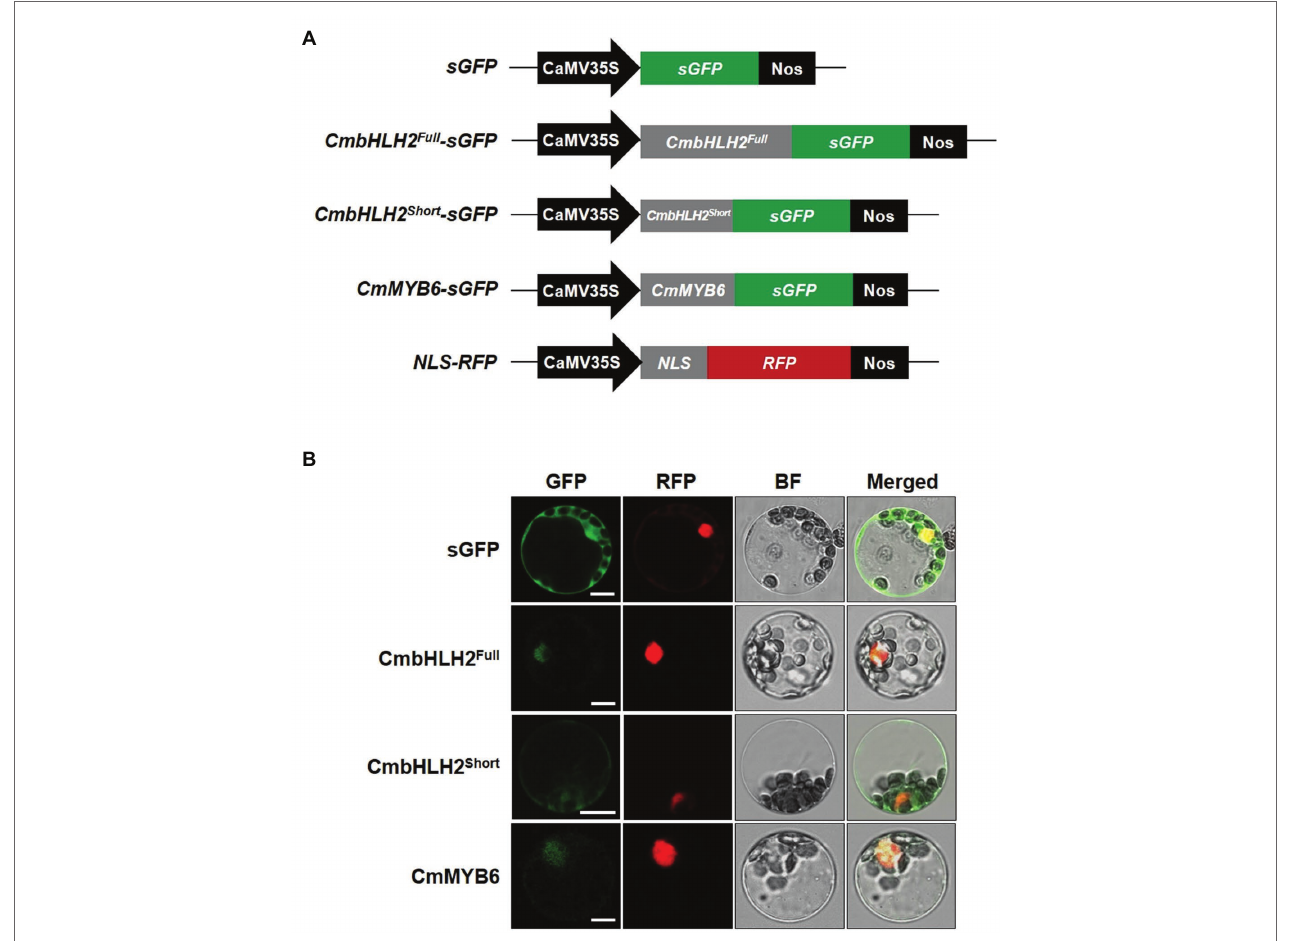
FIGURE 4 | Subcellular localization of CmbHLH2 Full , CmbHLH2 Short , and CmMYB6 in Arabidopsis leaf protoplasts. (A) Five constructs were used in this experiment: sGFP, soluble GFP; CmbHLH2 Full ::GFP, CmbHLH2 Full fused to GFP; CmbHLH2 Short ::GFP, CmbHLH2 Short fused to GFP; CmMYB6::GFP, CmMYB6 fused to GFP; and NLS::RFP, nuclear localization signal fused with RFP. (B) In vivo targeting of CmbHLH2 Full , CmbHLH2 Short , and CmMYB6 in Arabidopsis protoplasts. Data are representative of protoplasts expressing fusion proteins at 16 h after transformation. Bar = 10 μ